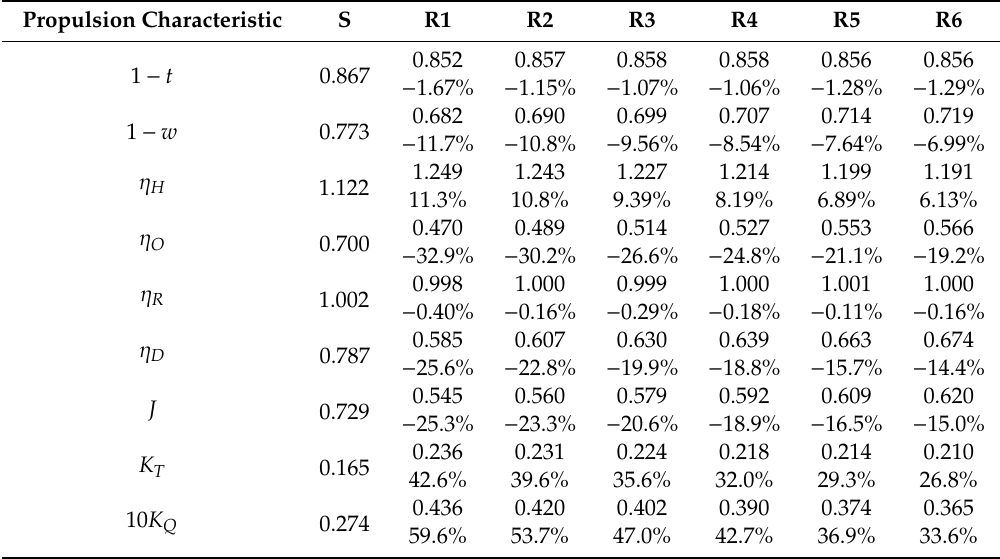
Table 14. The obtained impact of hard fouling on the propulsion characteristics for KCS. Propulsion Characteristic